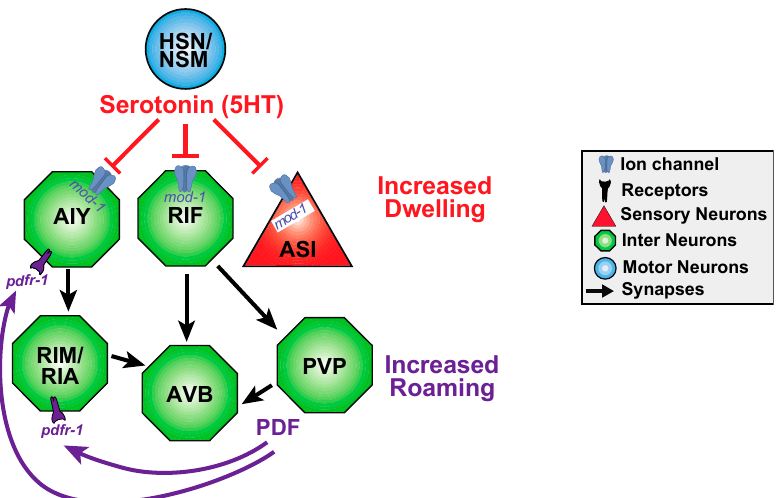
Figure 4. Functional circuits may be shaped by both neurotransmitters and neuropeptides and by short and long timescales. C. elegans display long-term behavioral dwelling or roaming states which are triggered by serotonin and PDF, respectively. PDF prolongs roaming and shortens dwelling states, whereas serotonin has reciprocal effects. PVP has been hypothesized to secrete PDF. Roaming and dwelling behavior seems to be modulated by a distributed circuit with the switch between dwelling and roaming is seemingly spontaneous. NSM neurons are implicated in feeding, and HSN neurons are implicated in egg laying. AIY and RIM neurons regulate reversal frequencies. ASI neurons are sensory neurons (triangles) that sense food, pheromones, to regulate dauer larva development. RIA interneurons regulate head curving during locomotion. AVB interneurons are forward command neurons in the motor circuit. Interestingly, functional connections can be extrasynaptic and defy sensory to motor circuit logic as HSN / NSM serotonin inhibits ASI in this behavior. Circuit adapted from Flavell et al.